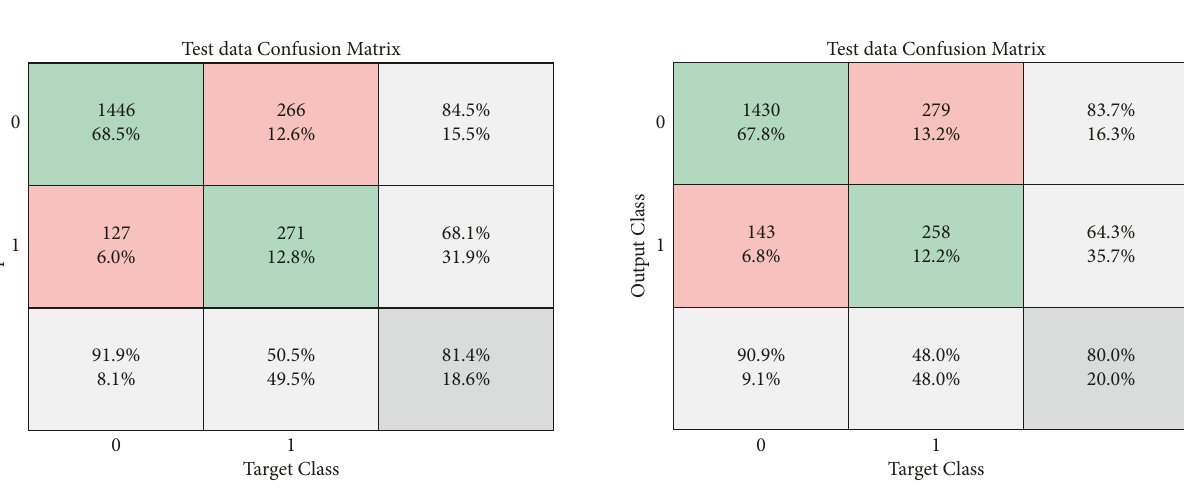
Figure 9: Confusion matrix obtained from the best performance of the proposed system in 10 runs.